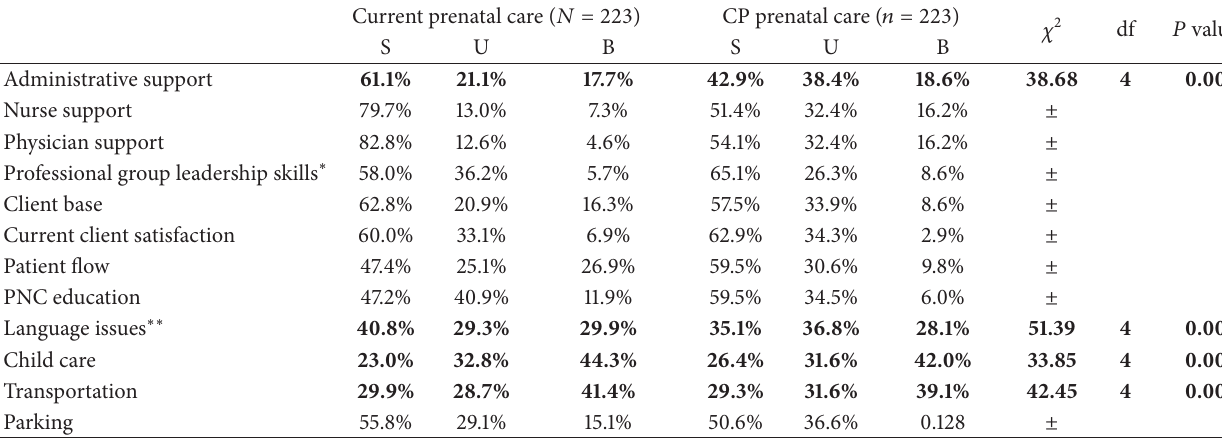
Table 5: Strengths and